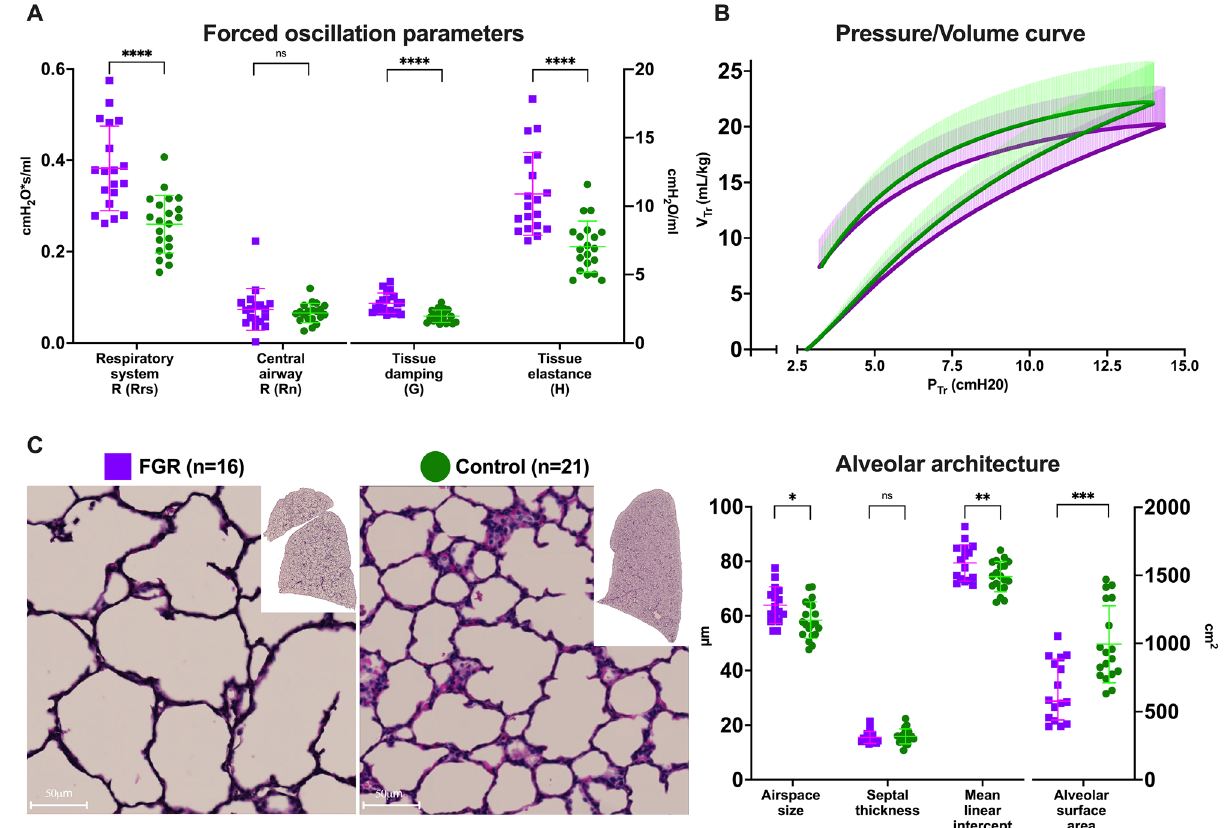
Figure 4. Pulmonary assessment in postnatal day 1. ( A , B ) Pulmonary function tests results from 19 FGR and 21 control subjects from 6 litters. ( C ) Representative images of histological H&E-stained slides (left) and alveolar architecture data (right) from 16 FGR and 21 control subjects from 6 litters. Data were analysed using a linear mixed-effects model and displayed as mean ± SD with significance as *0.05 ≥ p > 0.01; **0.01 ≥ p > 0.001.; ***0.001 > p > 0.0001; ****p <